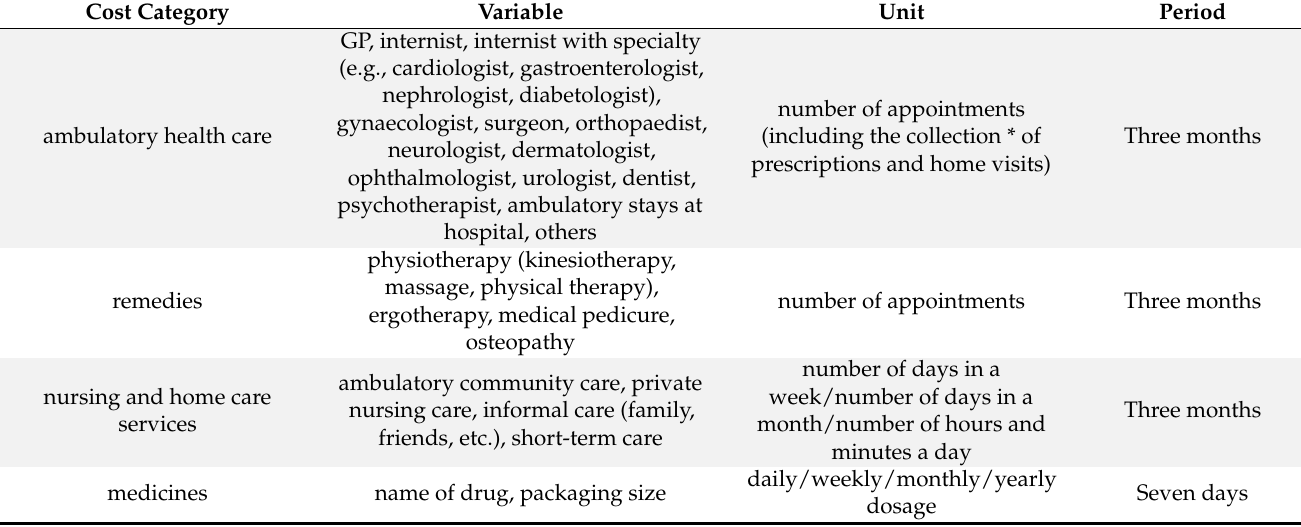
Table 1. FIMA: cost categories, variables, units, and time periods